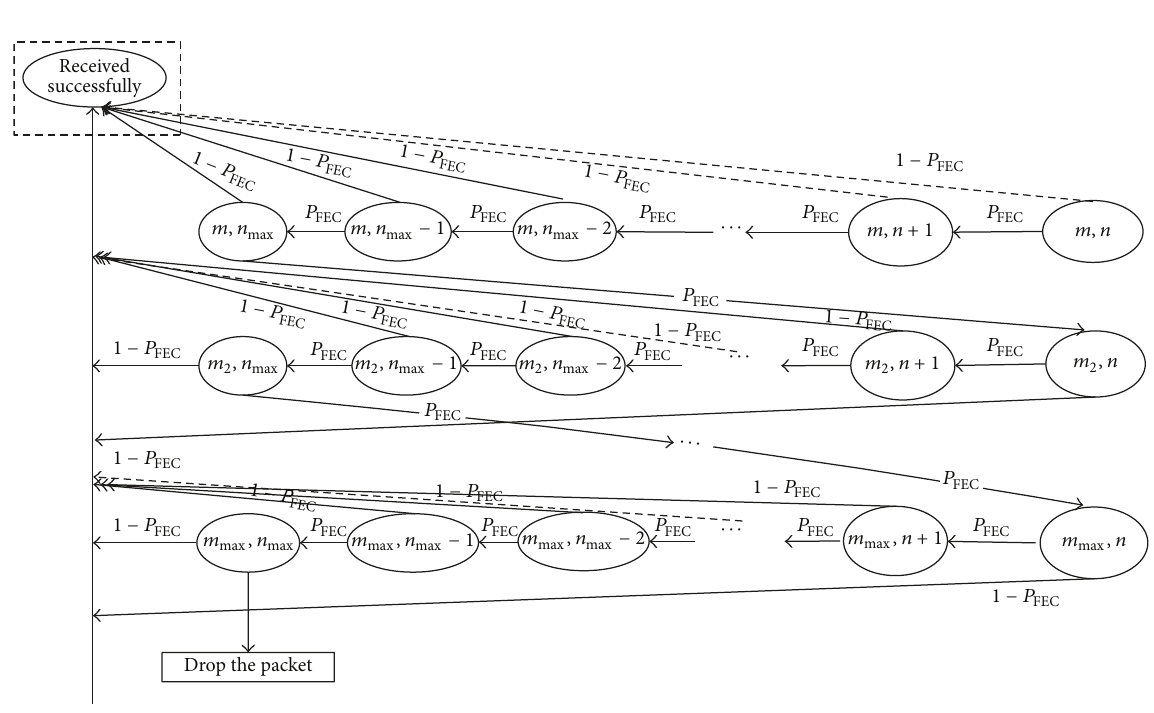
Figure 2: Markov chain model for FEC